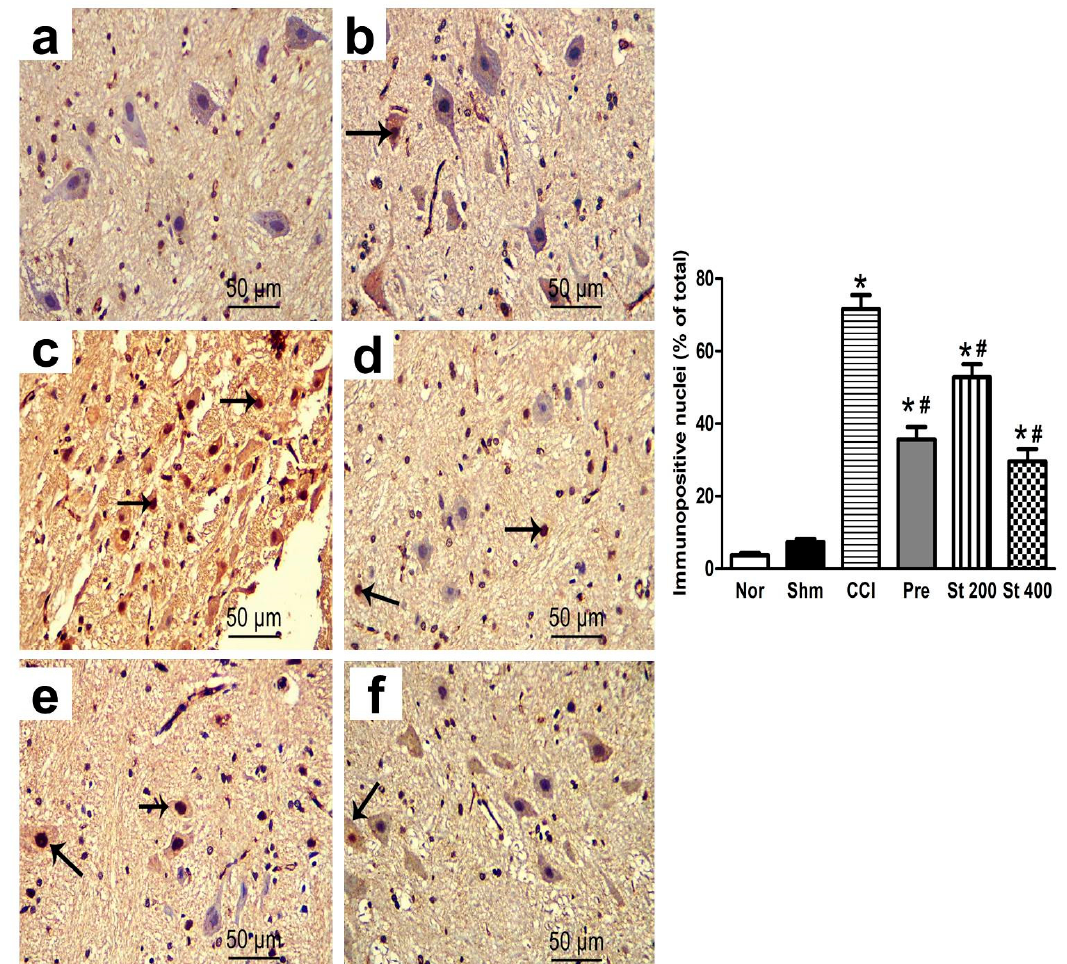
Figure 5. Representative photomicrographs showing the evaluation of the apoptotic cell populations via P53 ( a–f ) immunostaining of brain stems in: Normal ( a ); Sham ( b ); CCI ( c ); Pregabalin ( d ) S. tetrasperma (200 mg/kg) ( e ); S. tetrasperma (400 mg/kg) ( f ). Rats received different treatments for 14 days after which the animals were sacrificed, and tissues were collected. Arrows indicating dark brown staining of immunopositive cells nuclei. Scale bar; 50 μ m. Bar chart showing changes in the number of p53 positive cells (% of total) in the brainstem sections of all experimental groups. The immunopositive cells were counted in 3 non overlapping fields from 100% magnification ( n = 5 animals/ group). Scale bar, 50 μ m. * p < 0.05 vs. control values; # p < 0.05 vs. CCI group. Norm means normal group; Shm means Sham group; St 200 and St 400 mean S. tetrasperma extract (200 and 400 mg/kg) and pre means pregabalin group.